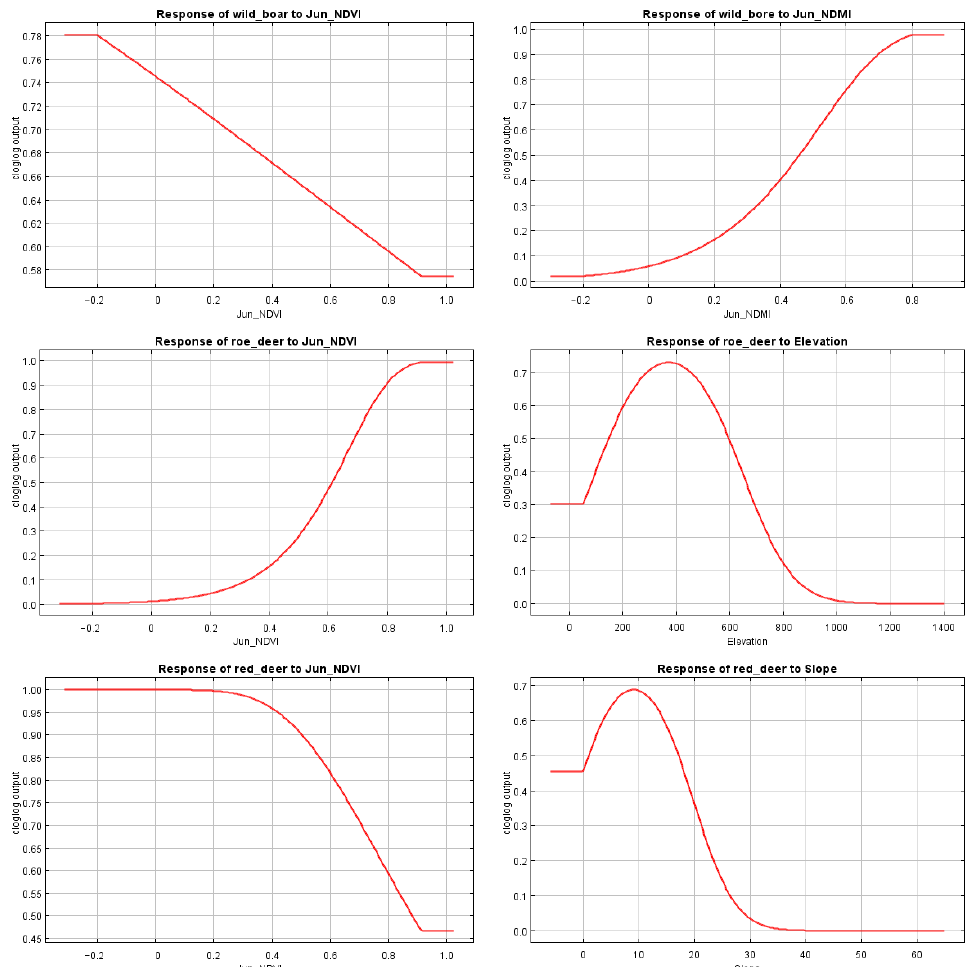
Figure 3. Response curves of three ungulates model prediction to environmental variables. Cloglog is the default model output, which is the simplest to understand: it gives a probability of species occurrence estimate between 0 and 1.